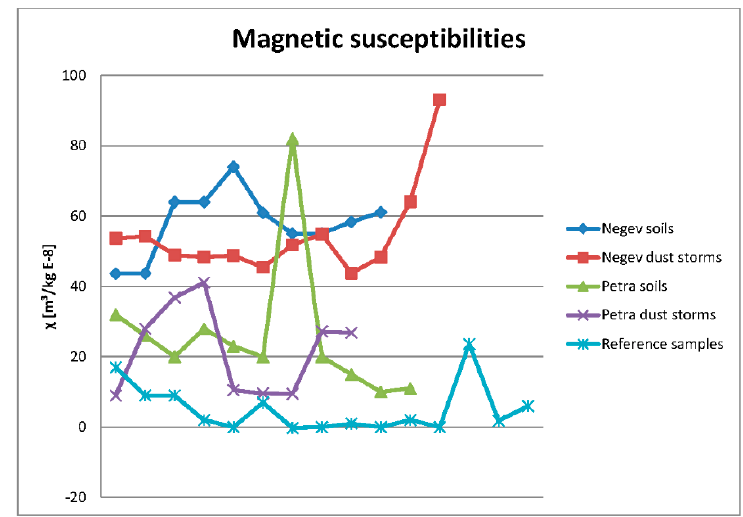
Figure 12. Variations of magnetic susceptibilities in the soils, sediments gathered in dust collectors (dust storms), and reference samples of the investigation regions. The x-axis represents individual samples of the respective categories (not numbered; see Table A5 in Appendix C for respective results).